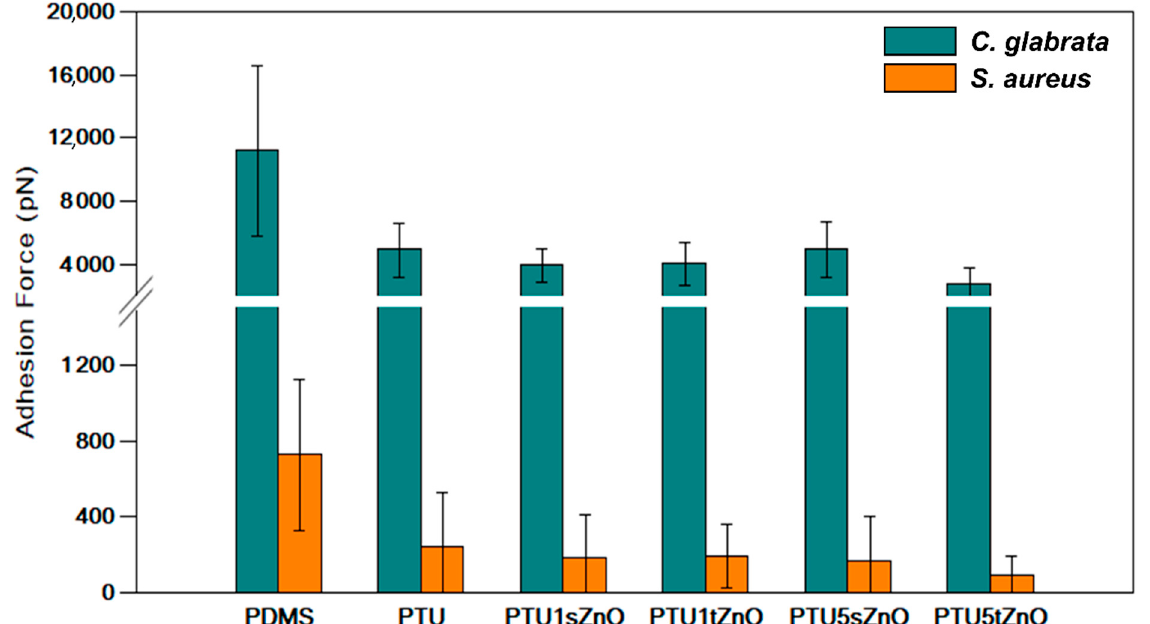
Figure 3. Recapitulative histogram showing the compared adhesion forces of S. aureus (orange bars) and C. glabrata (blue bars) to PDMS, PTU and PTU/ZnO composites.